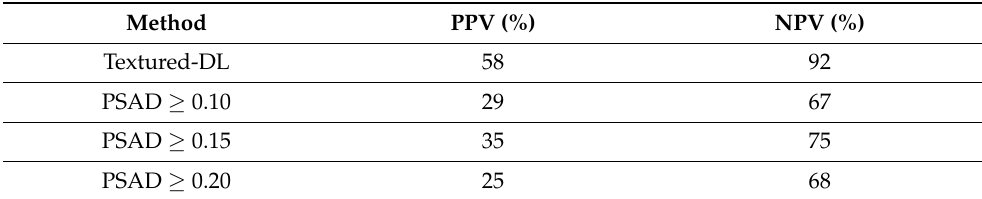
Table 4. PPV and NPV comparisons between Textured-DL and PSAD-based classification among lesions with a PI-RADS score of